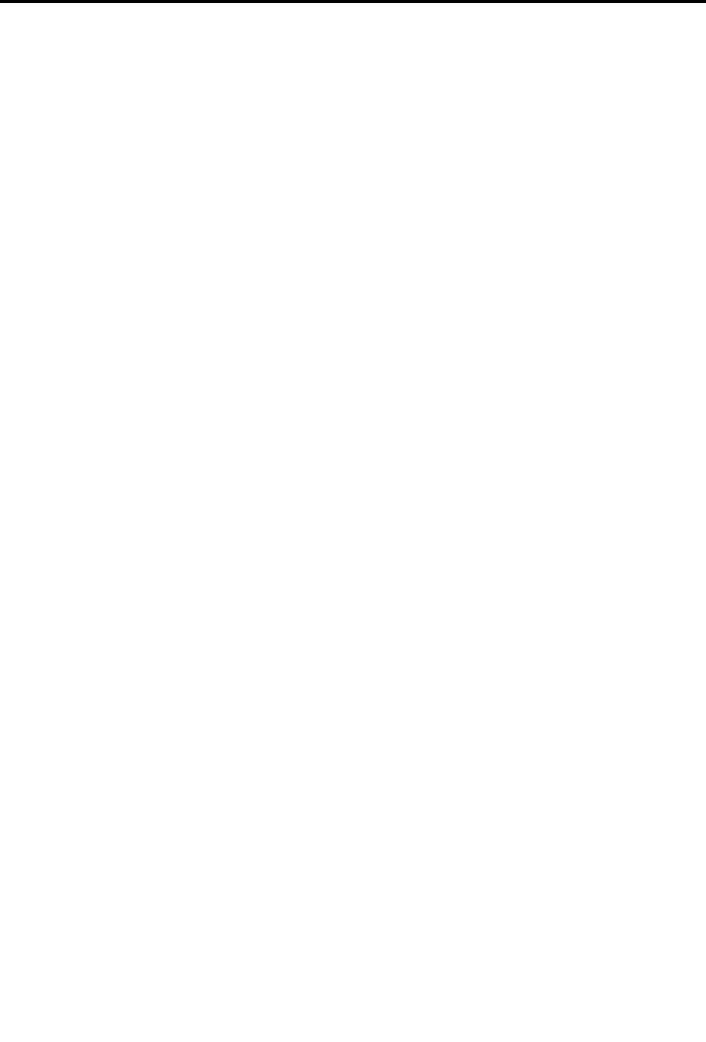
FIG. 2. Effect of DPI on IL-1-induced iNOS mRNA expression. Chondrocyte cultures were pretreated with the indicated concentrations of DPI for 2h. Then, IL-1 (20ng/ml) was added and the cells further incubated for 6h. iNOS and GAPDH mRNAs were detected by Northern blot, as described in Materials and methods. The results shown are representa- tive of three independent